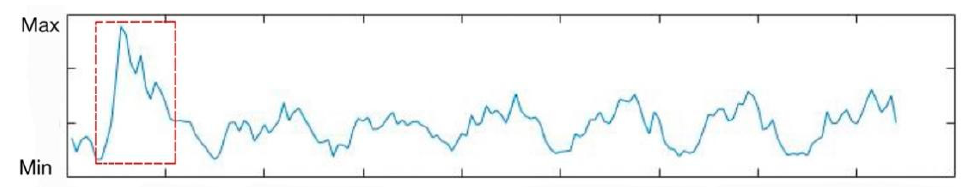
Figure 5. On the gathering of many anomalies.